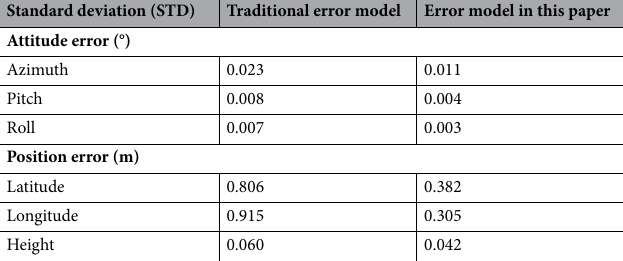
Table 4. The relative navigation errors for the imaging segment